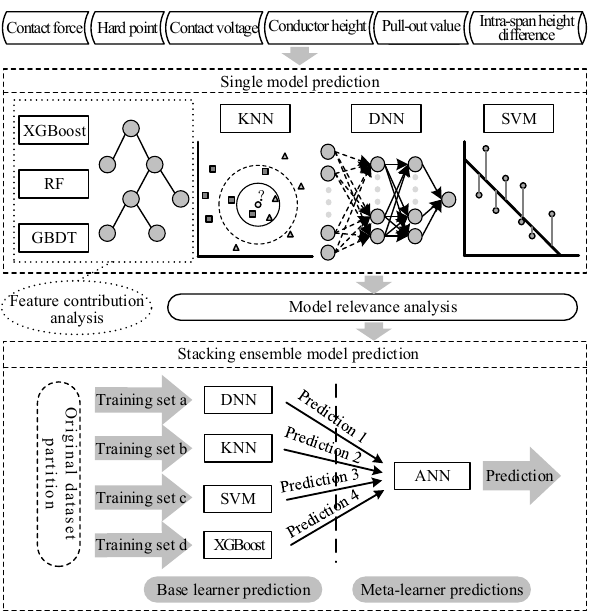
Figure 2. Design architecture of the RUL prediction model.